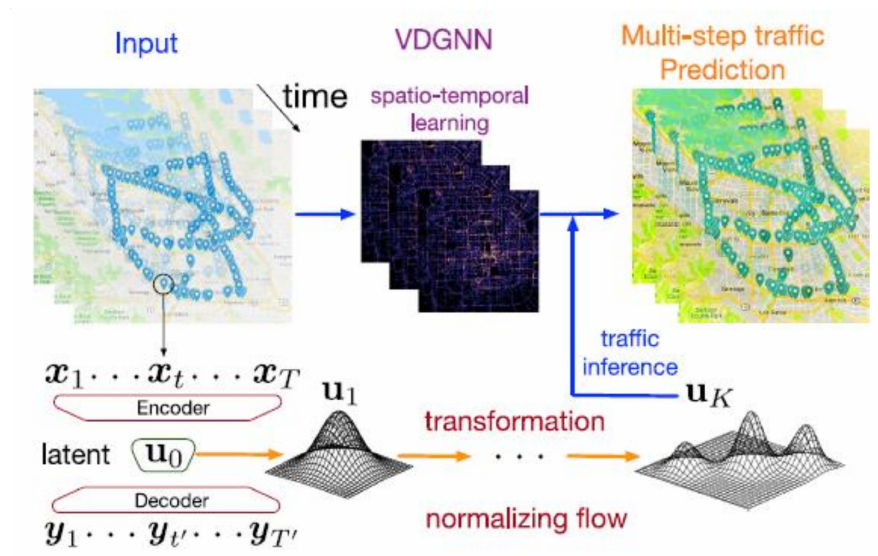
Figure 26. VGRAN framework for traffic forecasting [169].